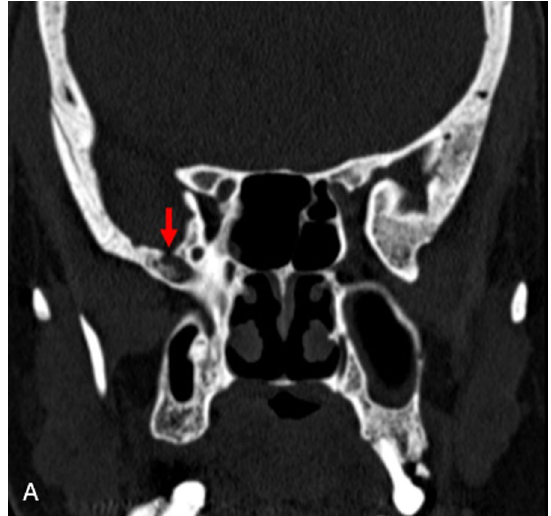
Fig. 5 CT cisternography coronal section in bone window demonstrating the bony defect in the right greater wing of sphenoid bone (red arrow) and resultant contrast opacification (red arrow)